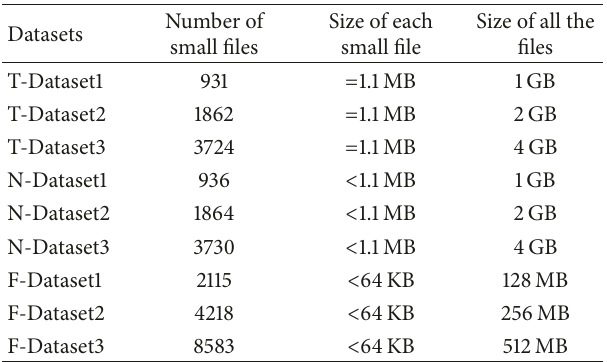
Table 3: The experimental datasets for performance evaluation of